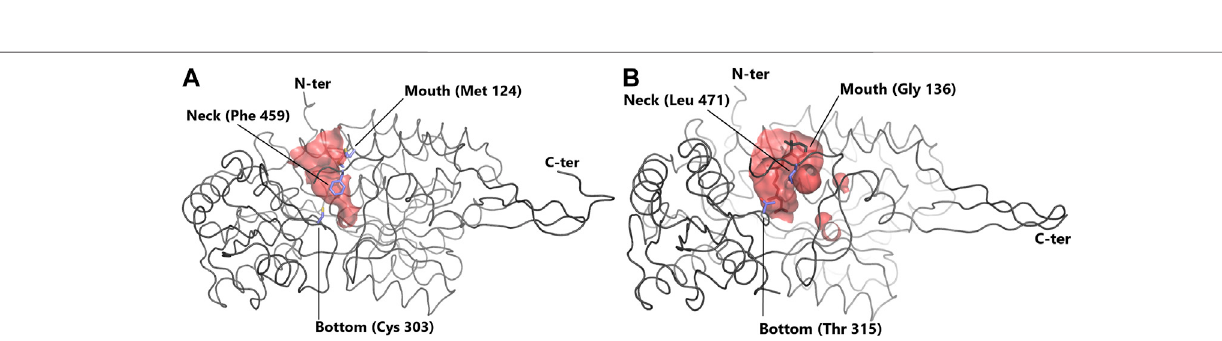
FIGURE 2 | Substrate entry channel (SEC) of ALDH. Surface representation of the SEC of (A) ALDH2 (PDB: 3N80) showing a narrow channel suitable for small aldehydes and (B) of the larger SEC ofALDH1A3 (PDB 5FHZ) with retinoic acid. SEC signature residues are shown in sticks. For clarity, residues 436 – 456 (ALDH2) and 437 – 466 (ALDH1A3) are not